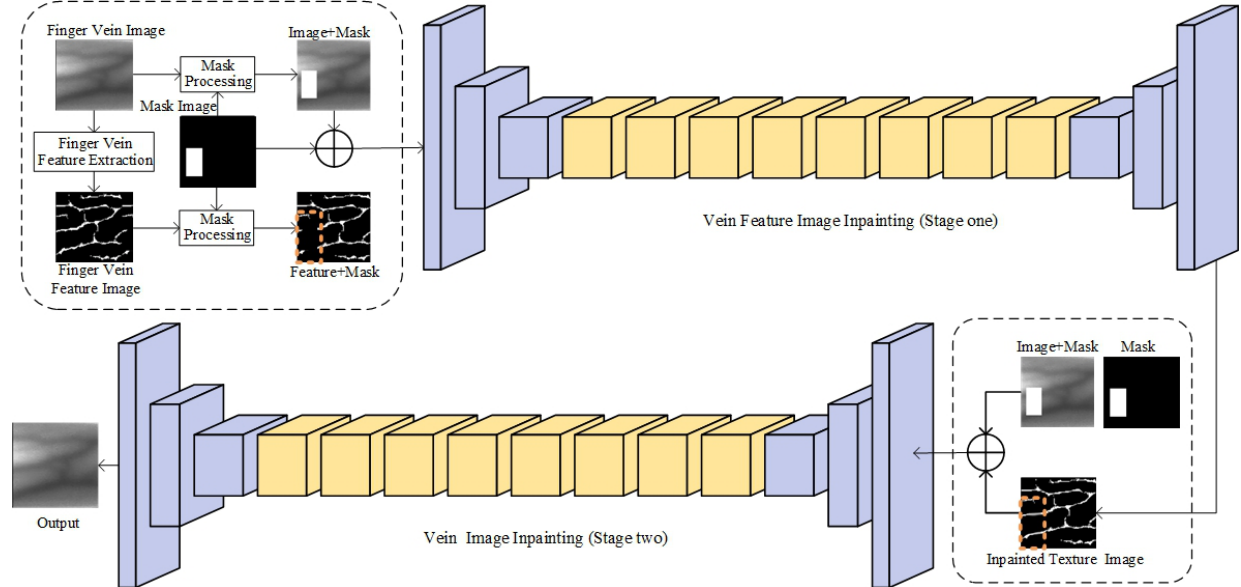
Figure 5. The feature-guided finger vein image restored based method of